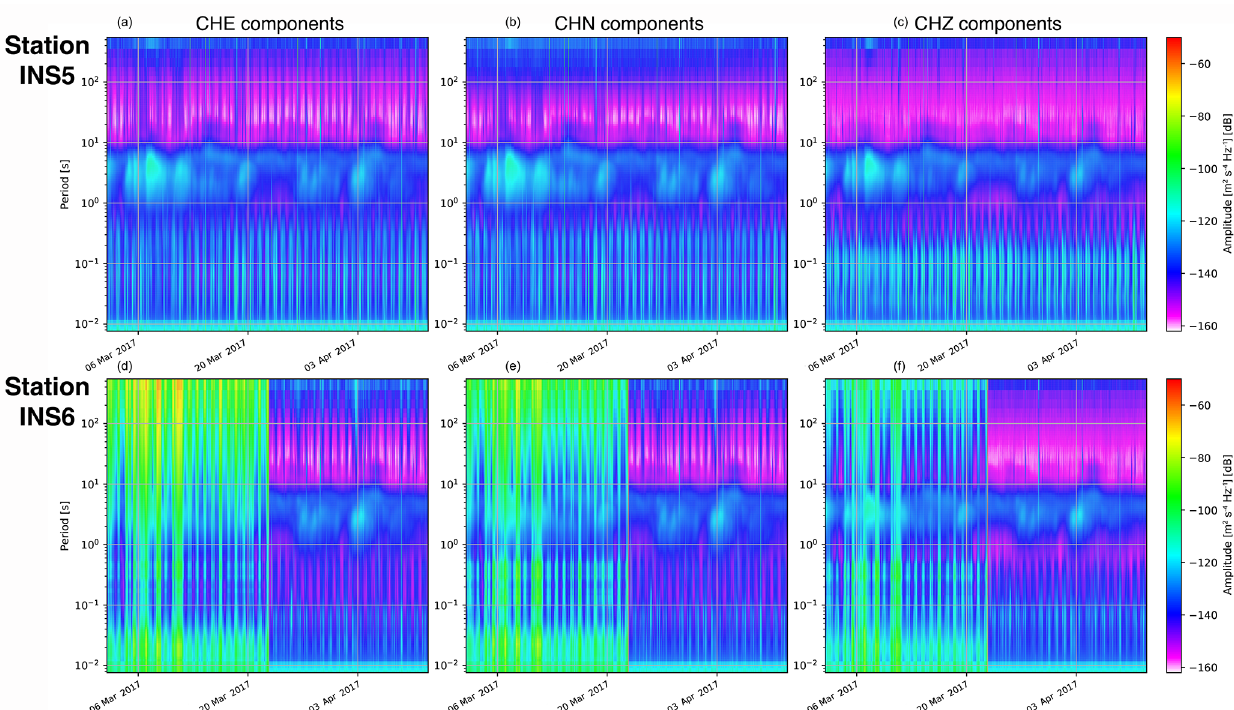
Figure 9. Spectrograms of each component of stations INS5 (a, b, c) and INS6 (c, d, e) computed over continuous data streams of 41d (from 2 March to 11 April 2017). The sensor of station INS5 was installed at 6m depth for the whole period of observation whereas the sensor of station INS6 was first installed on the surface and then moved at 6m depth on 22 March 2017.